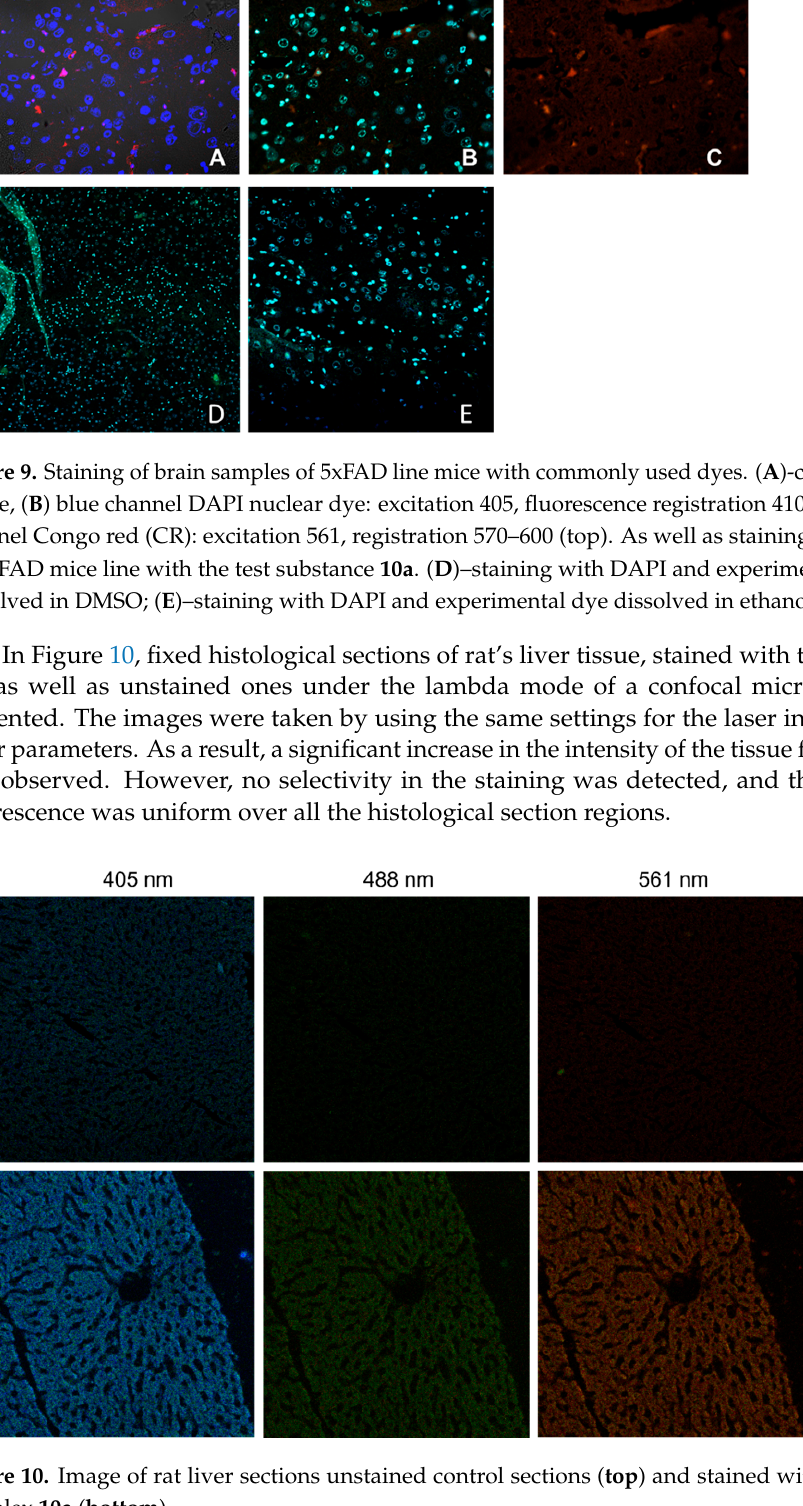
Figure 11 . Staining of Vero culture cells with complex 10a . Images for different excitation wave- lengths (405, 488, 514 and 561 nm) are presented. According to the pictures above, the cells stained with 10a showed the brightest flu- orescence upon the excitation with a 488 nm laser, with a maximum fluorescence intensity occurring at 530–540 nm. At the same time, the picture obtained with the excitation at 488 nm is sufficient to obtain an image with a relatively good resolution. However, this reso- lution is not the best one, probably, due to the insufficient fluorescence extensivity. To complete the visualization of the staining, the channel mode of the microscope was used, and the resulting fluorescence was accumulated and summarized in the range from 500 to 650 nm. The focus of the microscope was concentrated on the layer of cells adjacent to the substrate. The image was displayed in artificial colors, allowing it to obtain